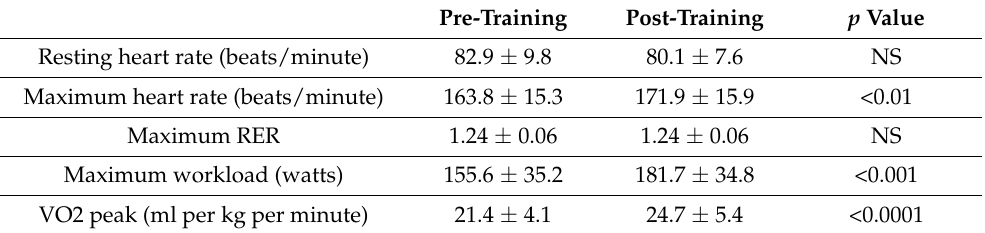
Table 2. Effect of aerobic exercise training on exercise capacity.